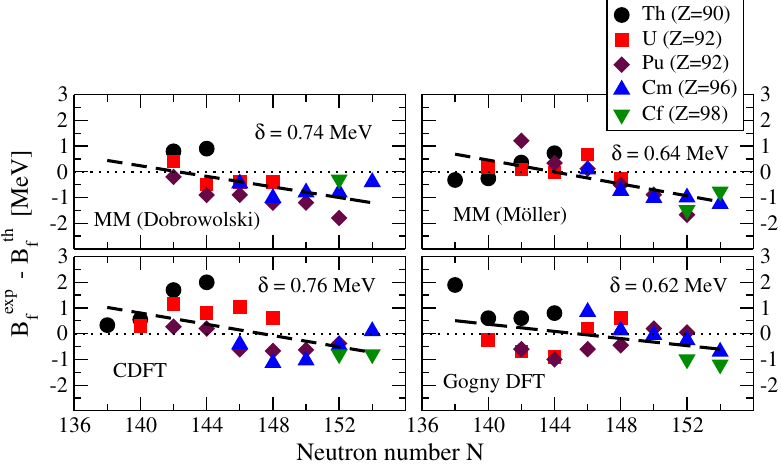
Figure 1. The difference between experimental and calculated heights of inner fission barriers as a function of neutron number N . The results of the calculations are compared to estimated fission barrier heights given in the RIPL-3 database [12]. The results of the calculations within the microscopic+macroscopic method (“MM(Dobrowolski)” [13] and “MM(Möller)” [14]), covariant density functional theory (“CDFT” [6]) and density functional theory based on the finite range Gogny D1S force (“Gogny DFT” [15]) are shown. The average deviation (cid:1) N | B i th ) − B i exp ) | /N , where N is the number of the barriers with per barrier (cid:3) [in MeV] is defined as (cid:3) = f ( f ( i = 1 known experimental heights, and B i f ( th ) ( B i f ( exp )) are calculated (experimental) heights of the barriers. Long- dashed lines represent the trend of the deviations between theory and experiment as a function of neutron number. From Ref.